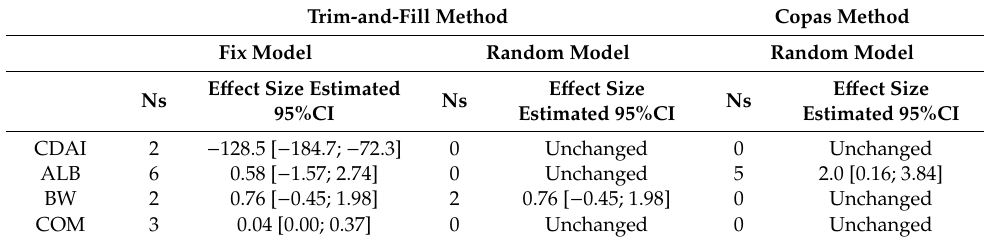
Figure 5. Funnel plot for: ( a ) Crohn’s Disease Activity Index (CDAI), ( b ) Albumin ( c ) Body Weight, and ( d ) Postoperative complications. The correspondence between the study and the number is shown in Table 2 (Id, Omitting). Table 4. Number of studies that should be added and the estimated effect size. Trim-and-Fill Method